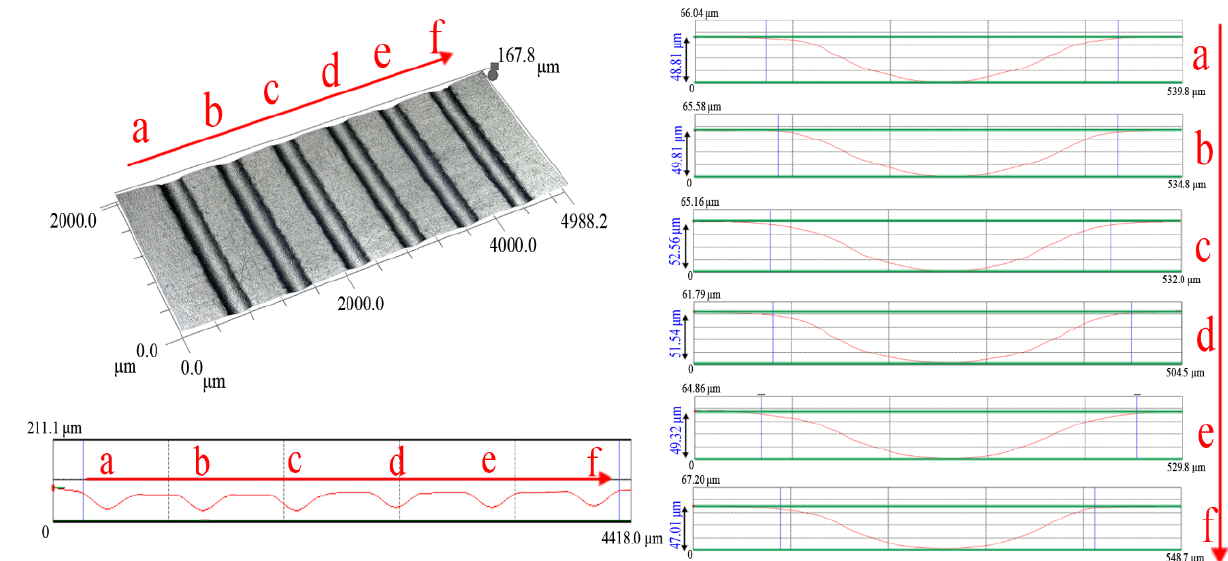
Figure 6. The 3D topography of the formed channels with the final load force 5011.19 N, the profile curves of the whole array micro-channel features (six channels, marked with a,b,c,d,e,f) with final load force 5011.19 N and the enlarged graphs of six profile curves of micro-channels (marked with a,b,c,d,e,f) with the final load force 5011.19 N.